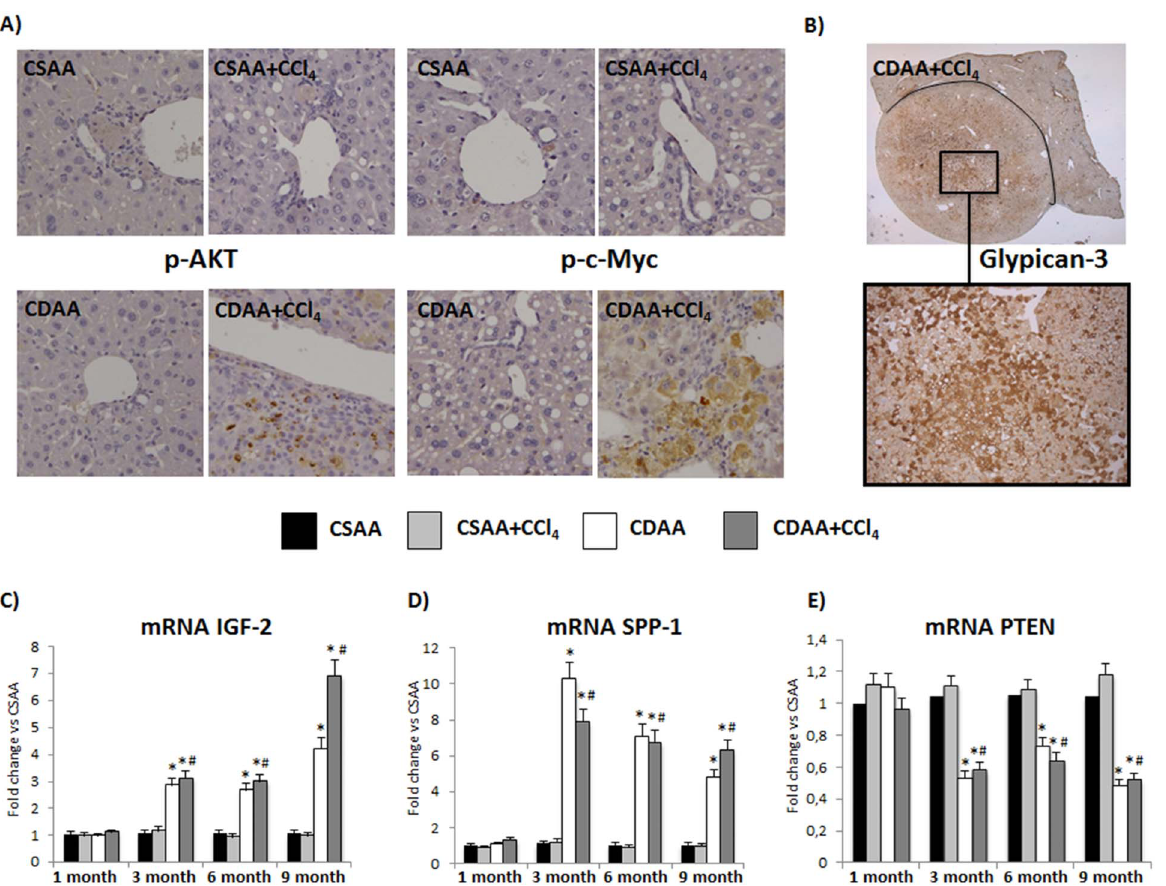
Figure 8. The expression of pro-carcinogenic genes is modified already after 3 months of treatment. A) Immunohistochemistry for p- AKT and p-c-Myc shows positive staining in the liver parenchyma of CDAA + CCl 4 mice, in correspondence of HCC foci (20X magnification) B) Glypican- 3 Immunohistochemistry shows positive staining in the tumor area (5X and 20X magnification). C) Mice treated with CDAA or CDAA + CCl 4 show, starting at 3 months, increased levels of mRNA for IGF-2 and (D) SPP-1 and (E) decreased mRNA levels of PTEN. Data represent mean 6 SD; *p , 0.05 vs CSAA; # p , 0.05 vs CSAA + CCl 4 .